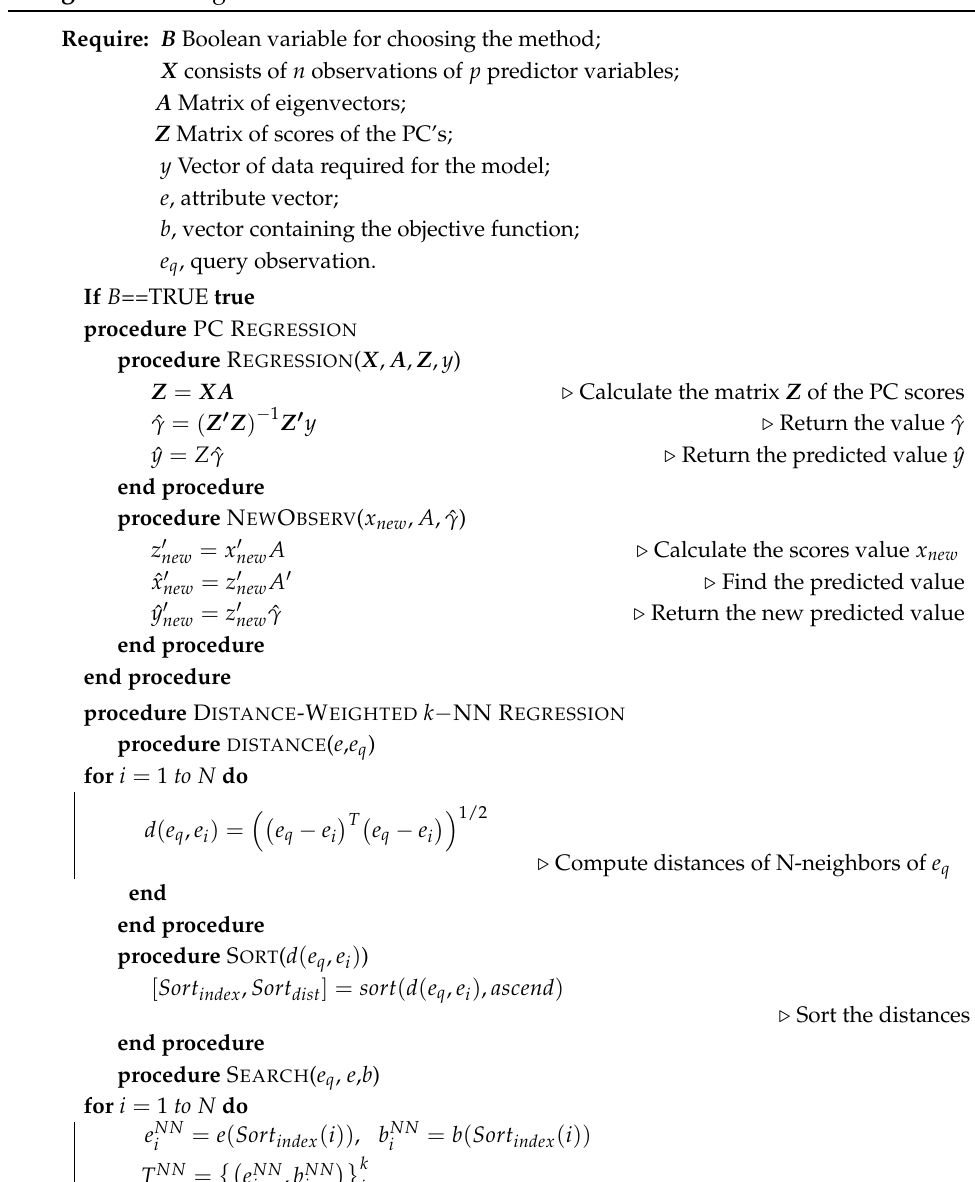
Algorithm 1: Regression